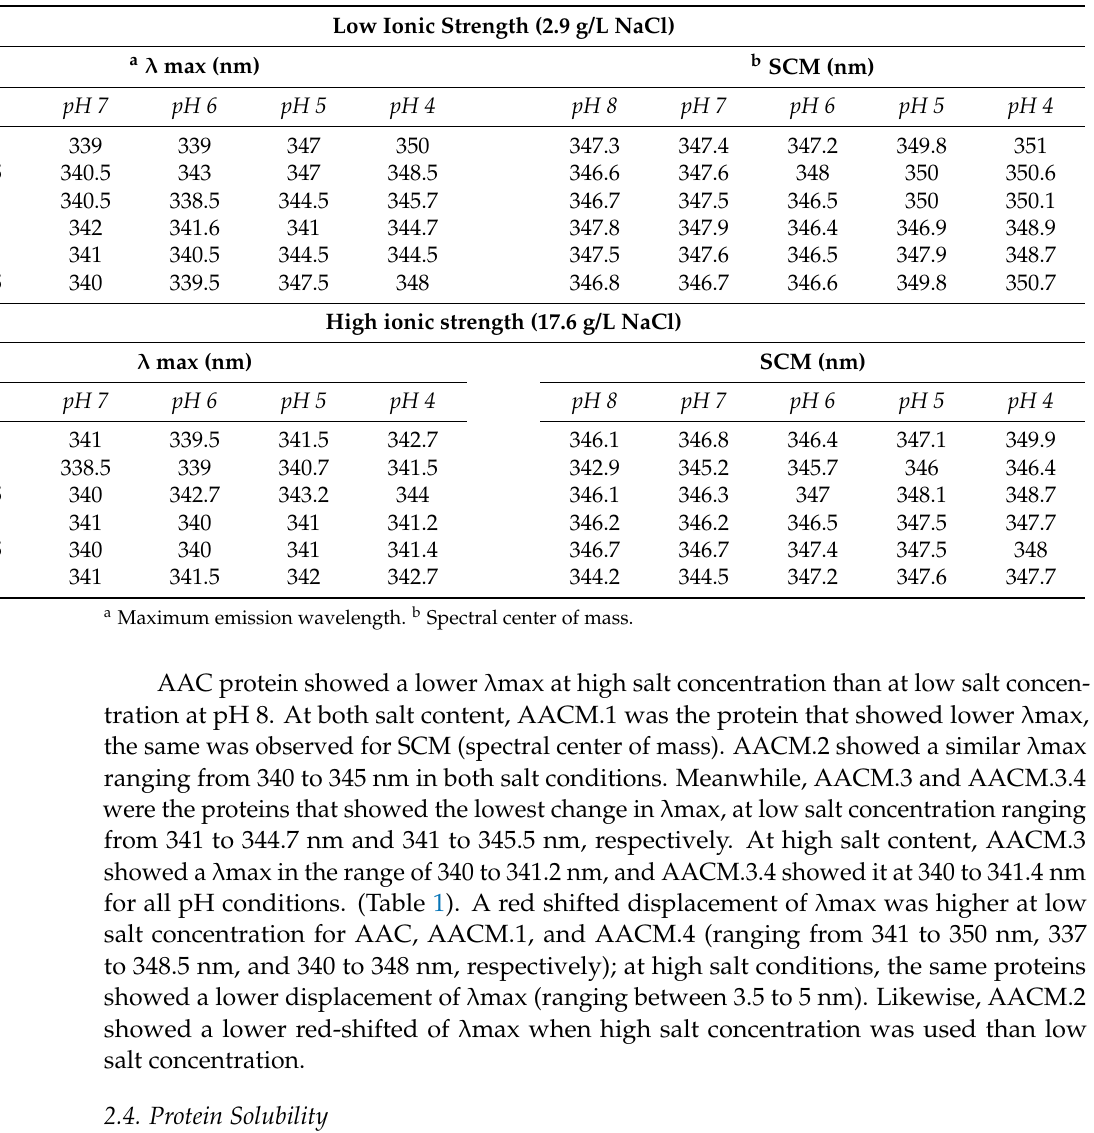
Table 1. Effect of pH and ionic strength treatments on the intrinsic fluorescence of AAC and their modified